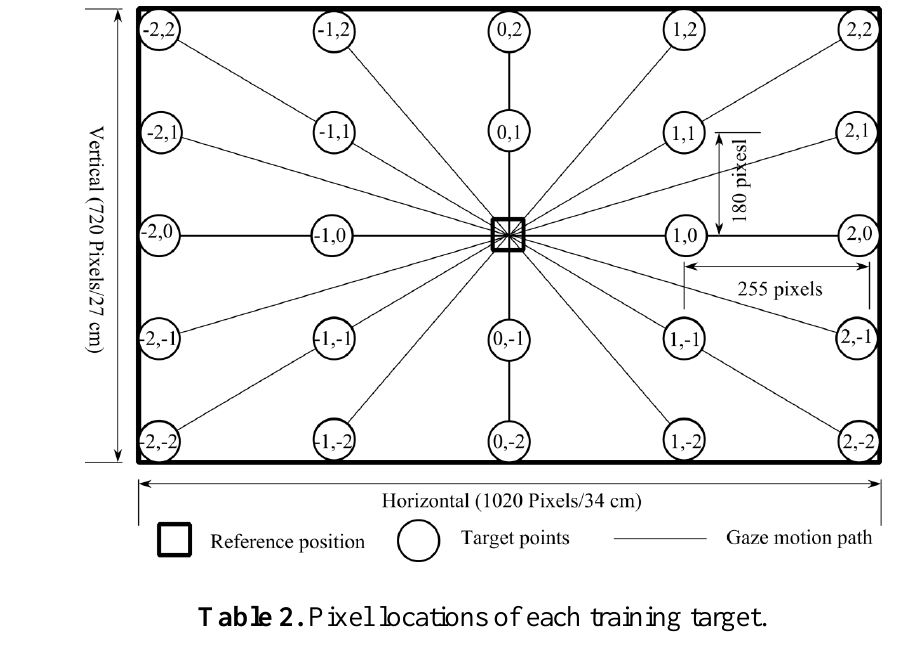
Figure 6. Training targets and eye reference positions.